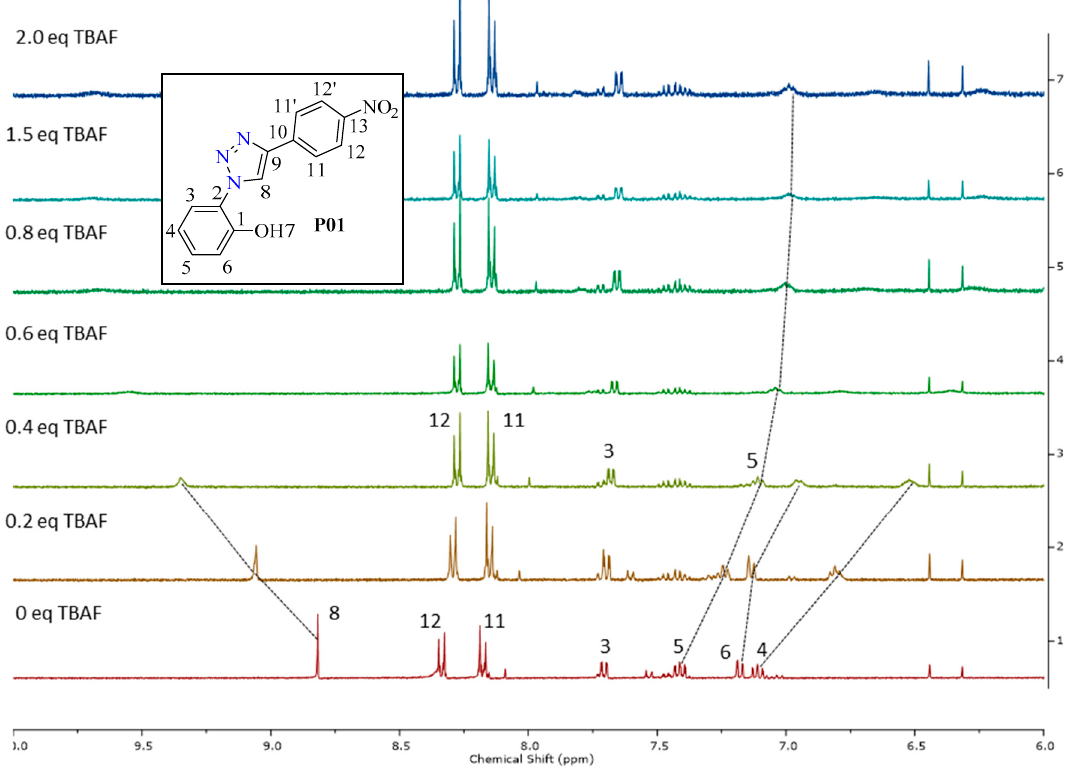
Figure 2. 1 H NMR experiments with P01 and increasing equivalents of TBAF in deuterated acetonitrile (CD 3 CN).